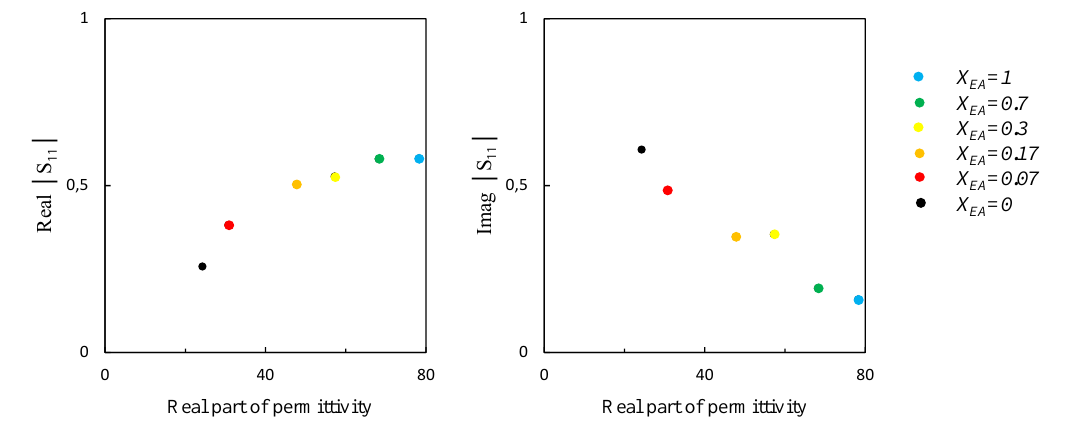
Figure 3. Experimental │ S11 │ parameters of the sensor recorded at 1 GHz for ethanol/water mixtures retrieved at 20 °C and mole fractions XEA of